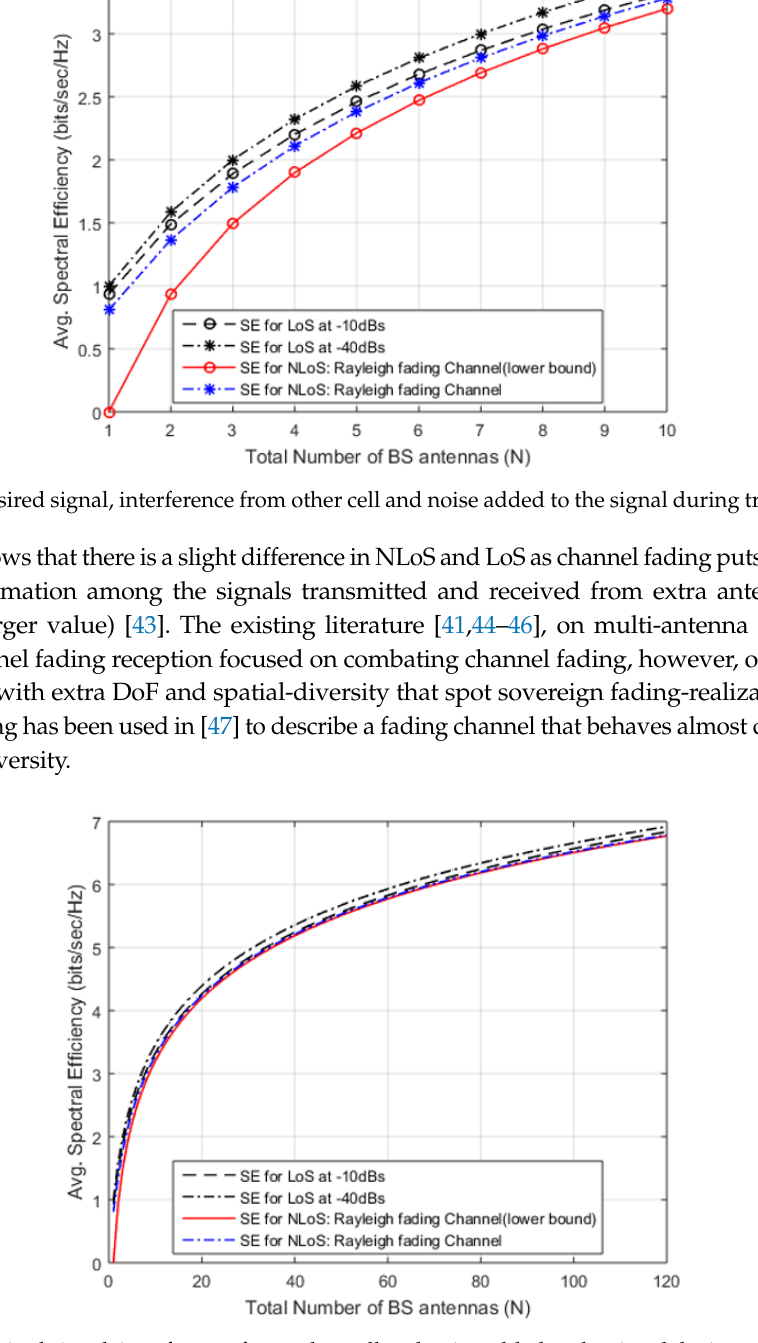
Figure 9. Desired signal, interference from other cell and noise added to the signal during